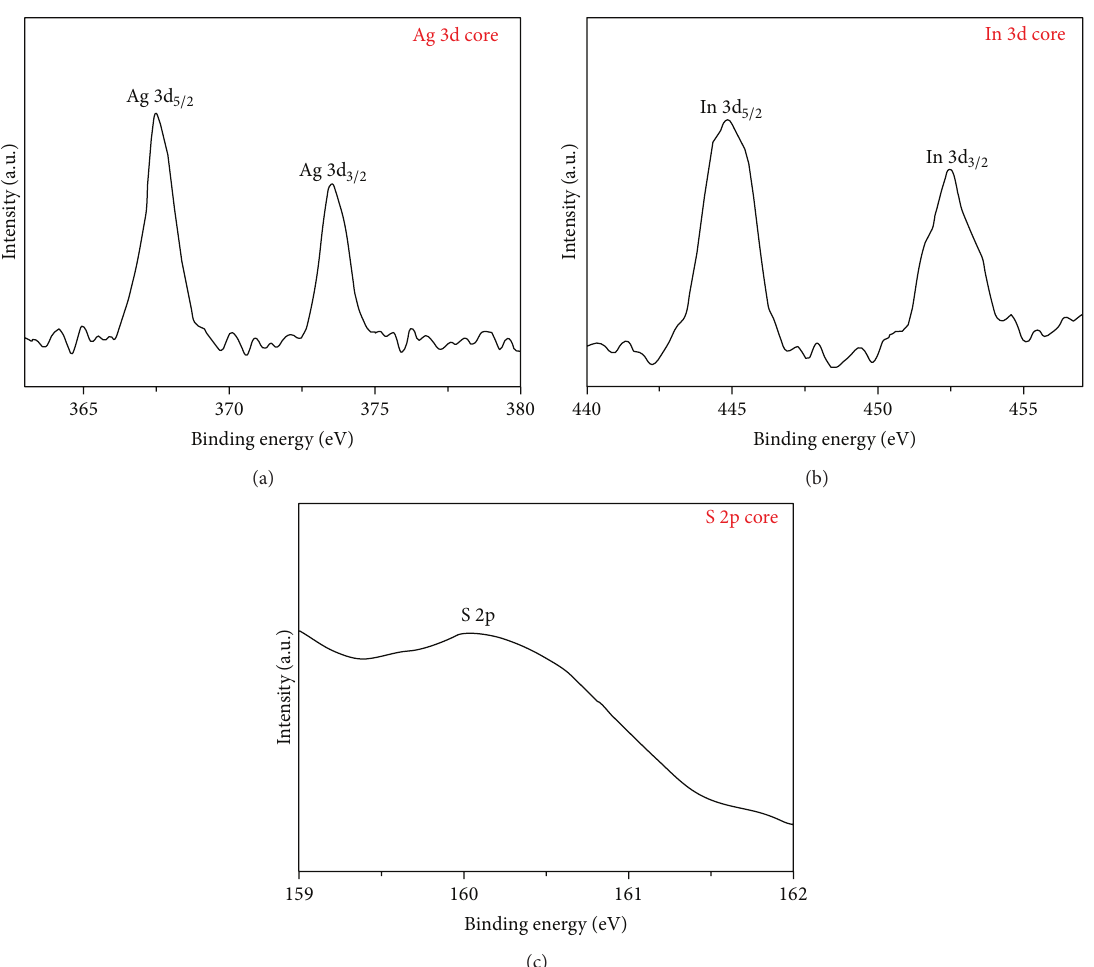
Figure 3: XPS pattern of AgInS 2 nanocrystal: (a) Ag 3d core level spectrum; (b) In 3d core level spectrum; (c) S 2p core level spectrum.